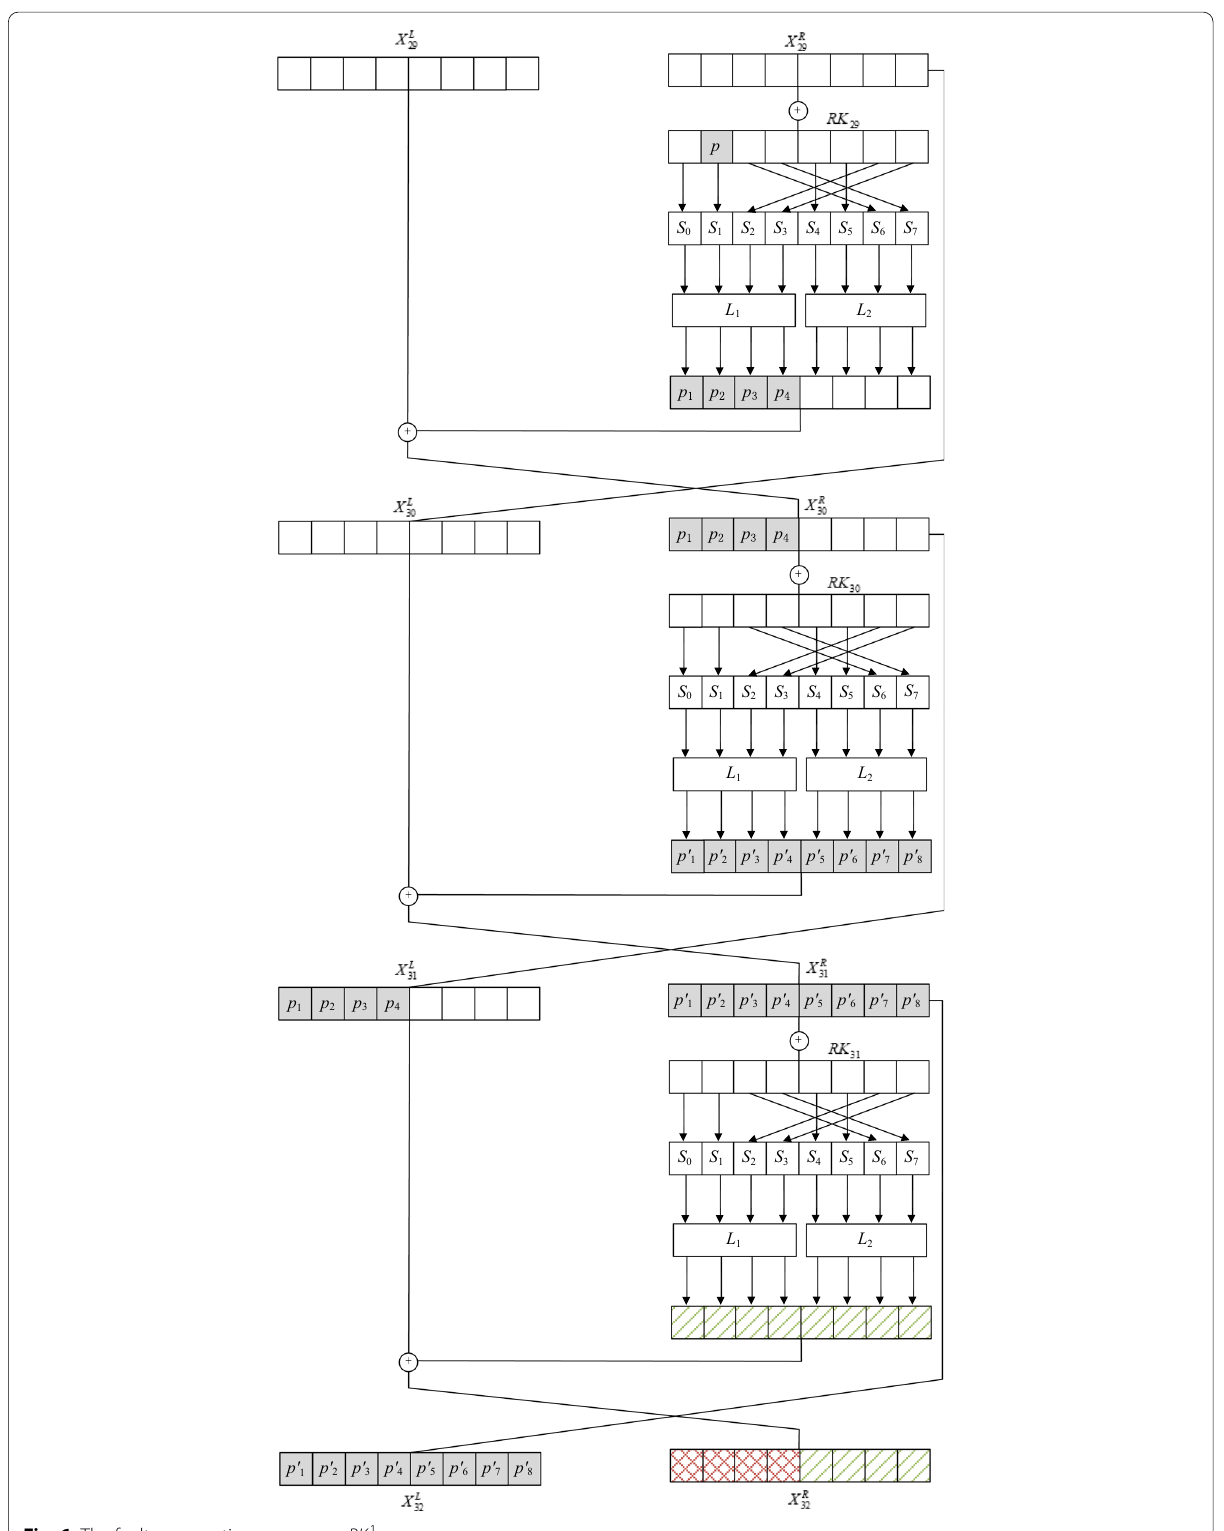
Fig. 6 The fault propagation process on RK 1